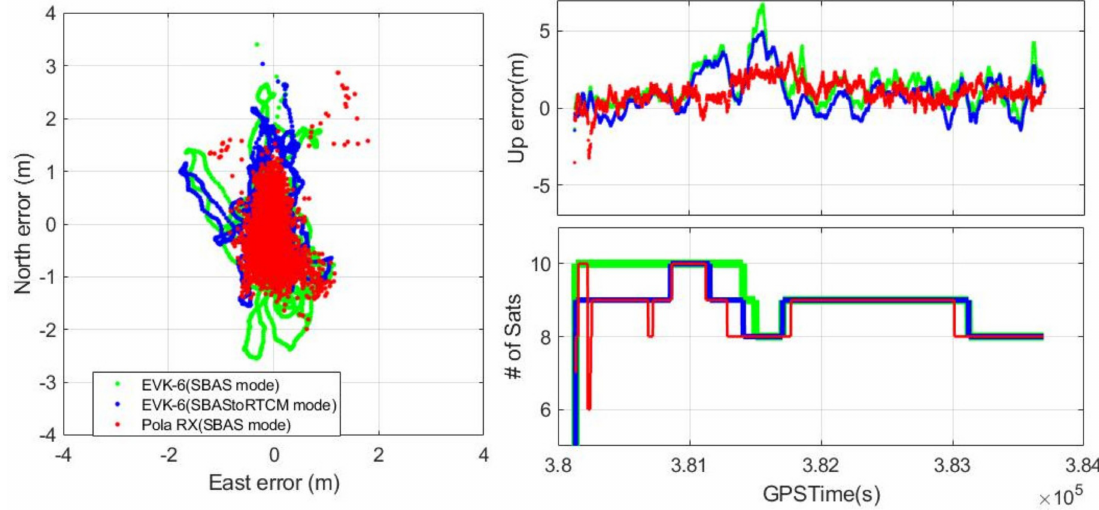
Figure 9. Static test positioning